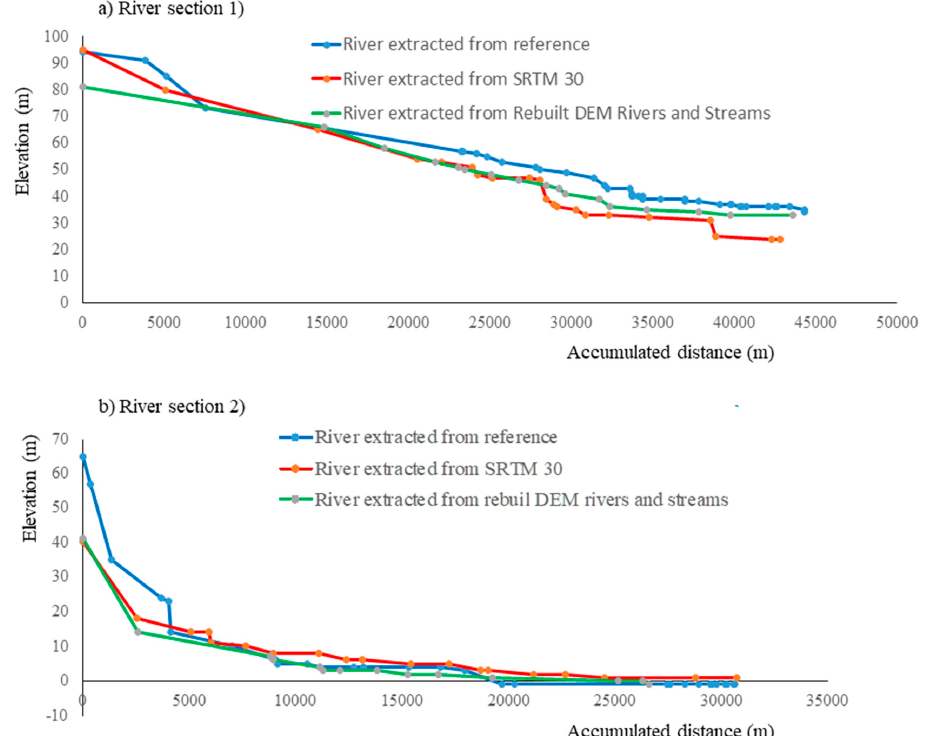
Figure 24. Profiles of a river sections indicated as (1) and (2) in Figure 22.